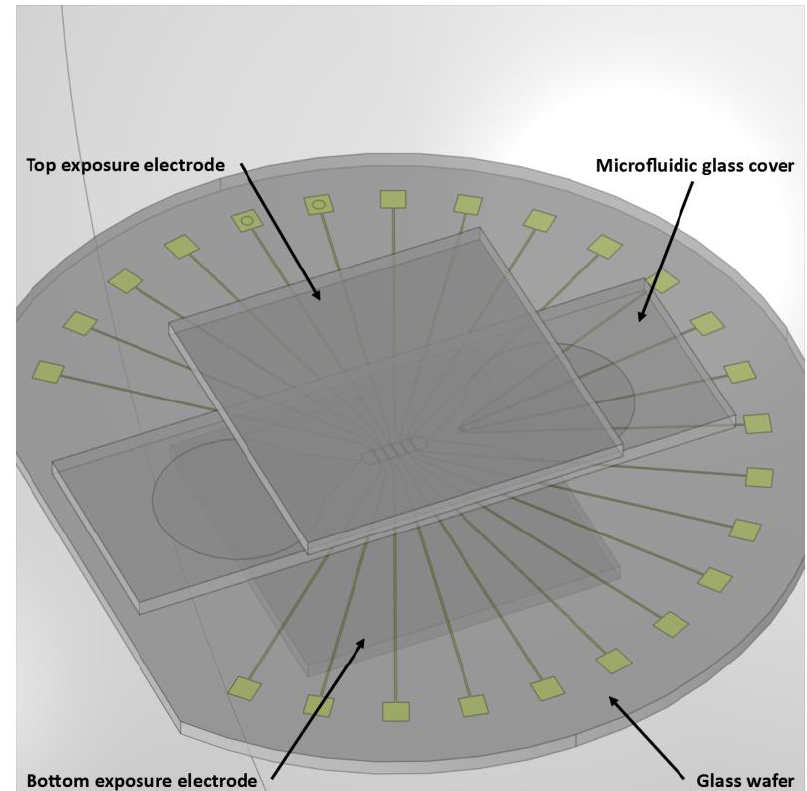
Figure 4. Device model in the FEM simulation.